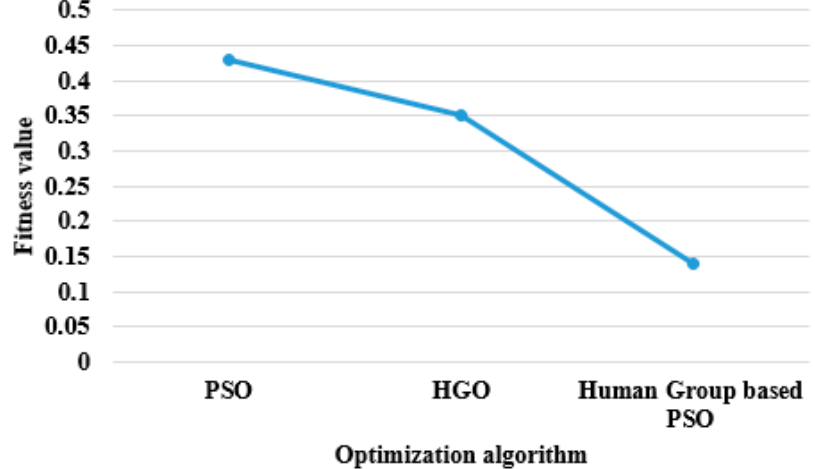
Figure 4. Graphical comparison of best fitness values.